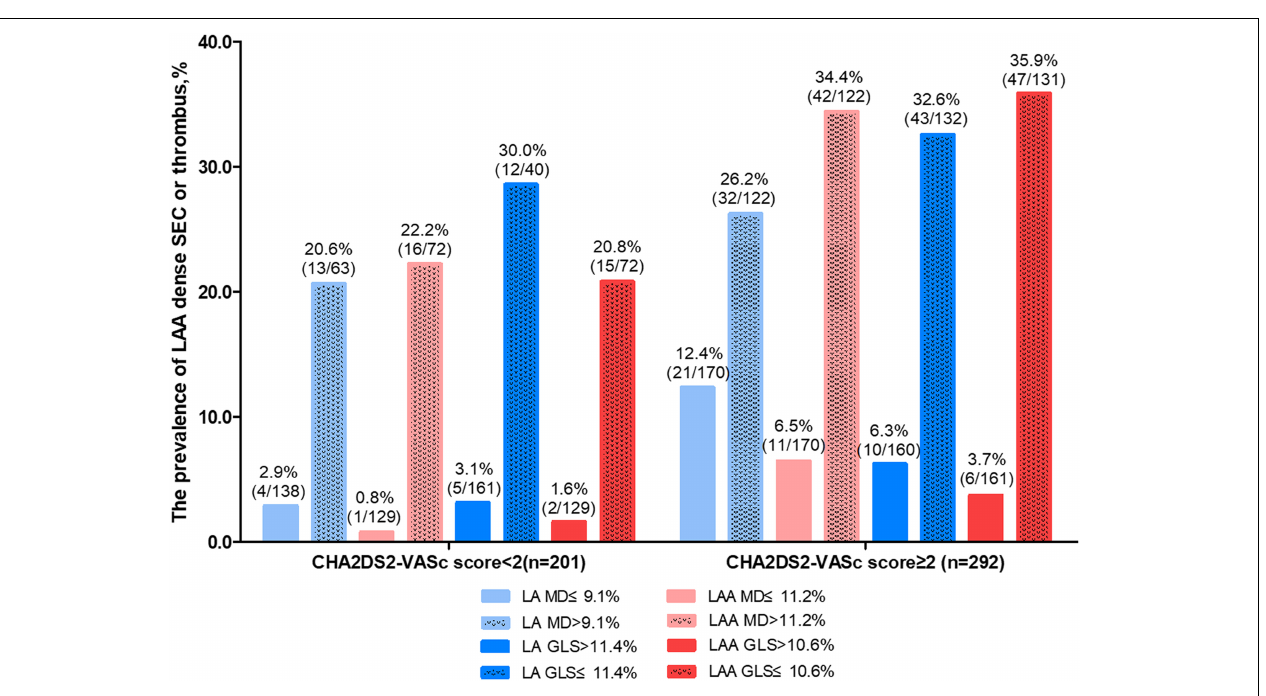
FIGURE 4 | The prevalence of LAA dense spontaneous echo contrast or thrombus according to LA/LAA mechanics and CHA2DS2-VASc score. GLS, global longitudinal strain; LA, left atrium; LAA, left atrial appendage; MD, mechanical